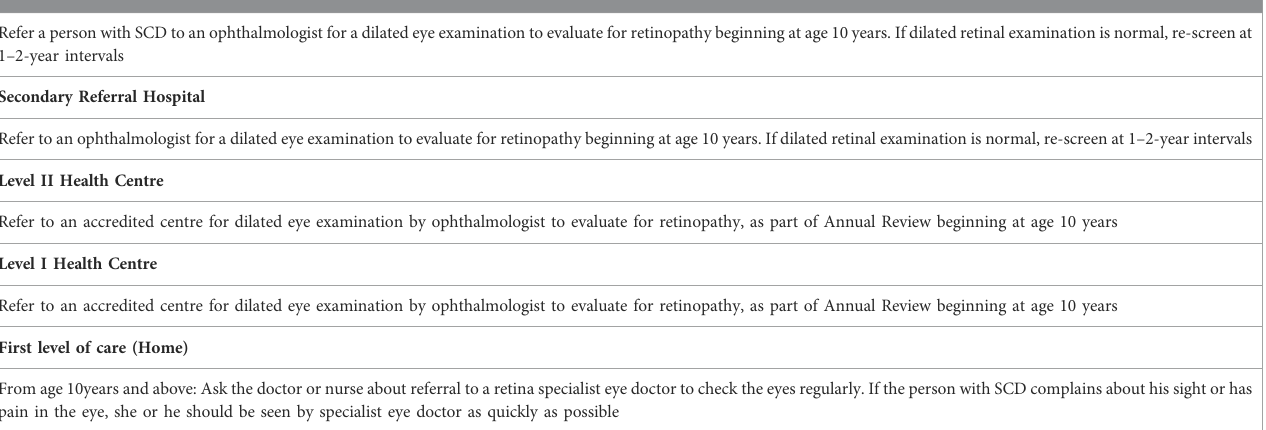
TABLE 6 Screening for retinopathy SCD disease patients for different healthcare levels. Last referral hospital